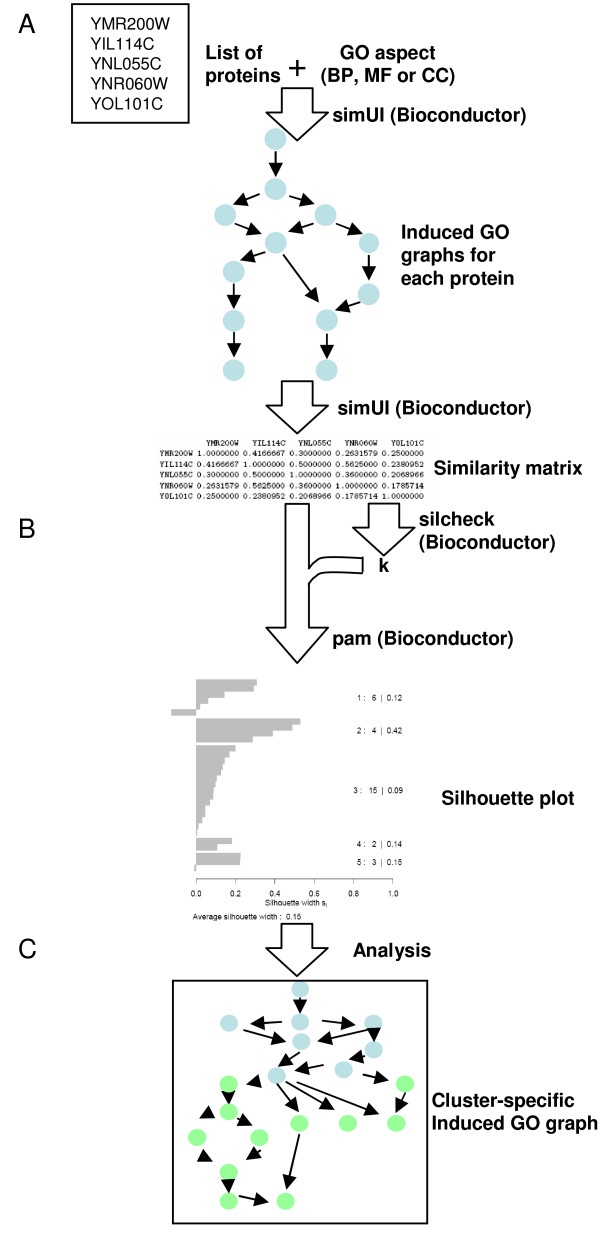
Methodology for clustering a list of proteins by graph similarity of Gene Ontology annotation. (A) The input to the methodology consists of a list of proteins and selection of one aspect of the Gene Ontology, i.e., Biological Process (BP), Molecular Function (MF) or Cellular Component (CC). The Bioconductor method simUI is then employed to generate a matrix of graph similarities between each pair of proteins in the list. (B) The Bioconductor method silcheck uses the similarity matrix to select the number of clusters, k. The Bioconductor method pam uses the similarity matrix and k to cluster the proteins. (C) The clustering result is then examined in further detail to produce a biological interpretation of the GO annotation of the inputted list of proteins.